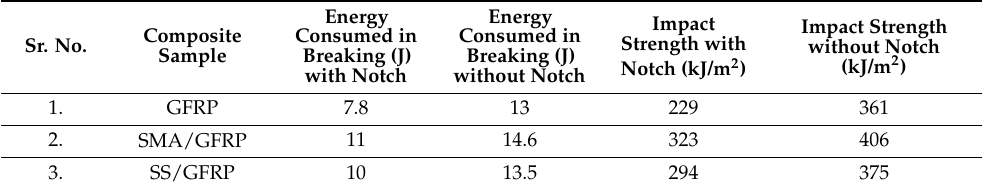
Table 3. Results of Charpy Impact Test set B. Sr.